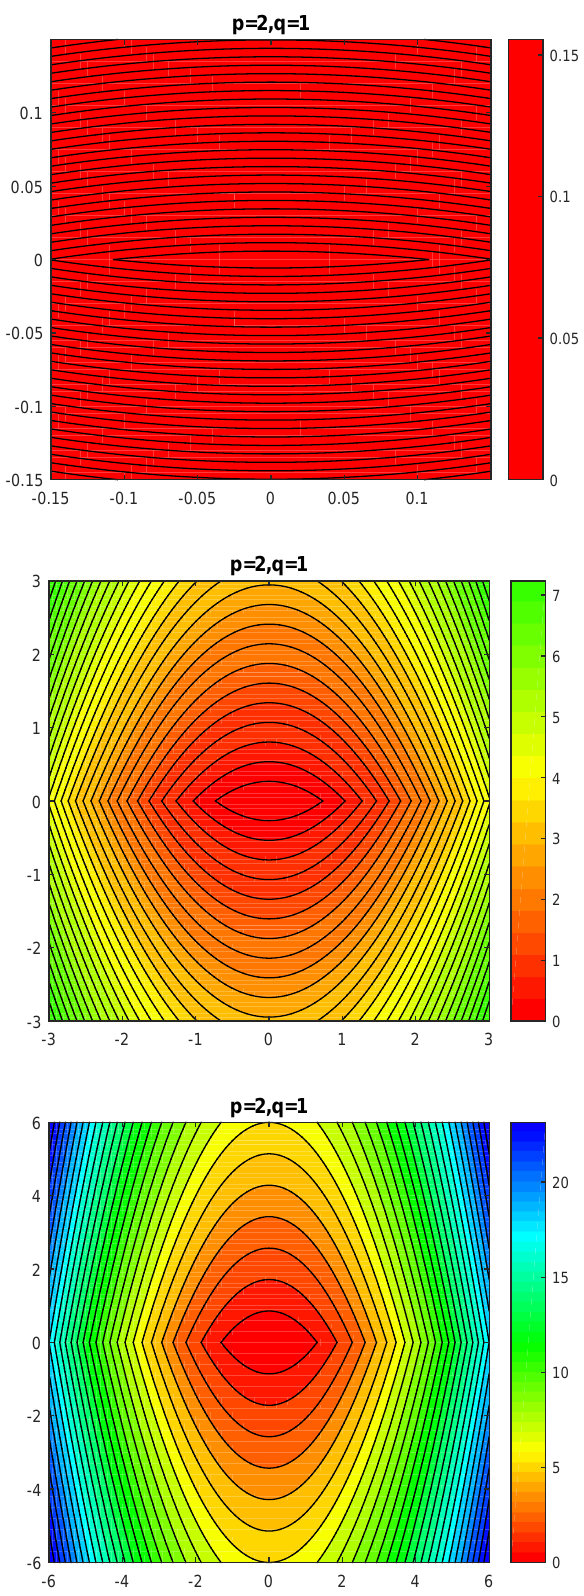
Figure 2. Gauss–Laplace density level sets: from local (central) to global